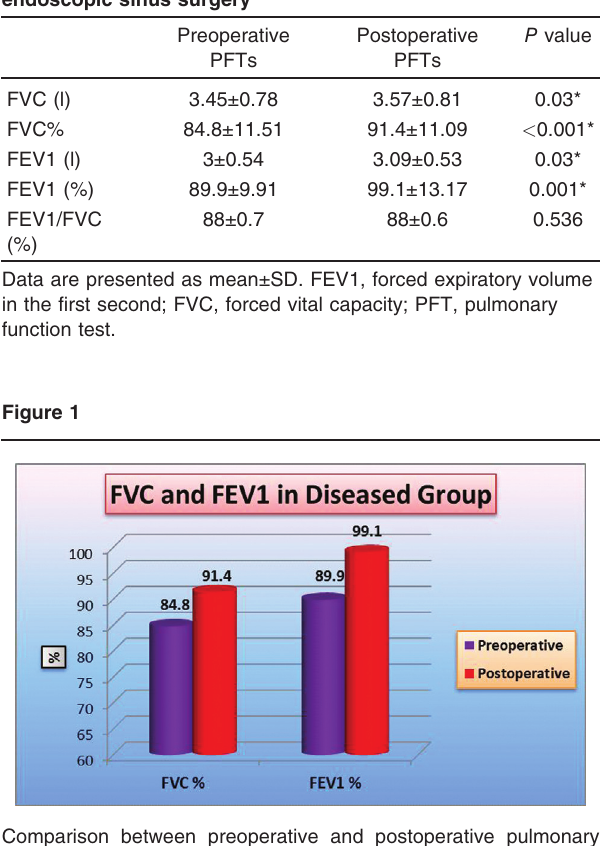
Comparison between preoperative and postoperative pulmonary function tests in patients undergoing endoscopic sinus surgery. FEV1, forced expiratory volume in the first second; FVC, forced vital